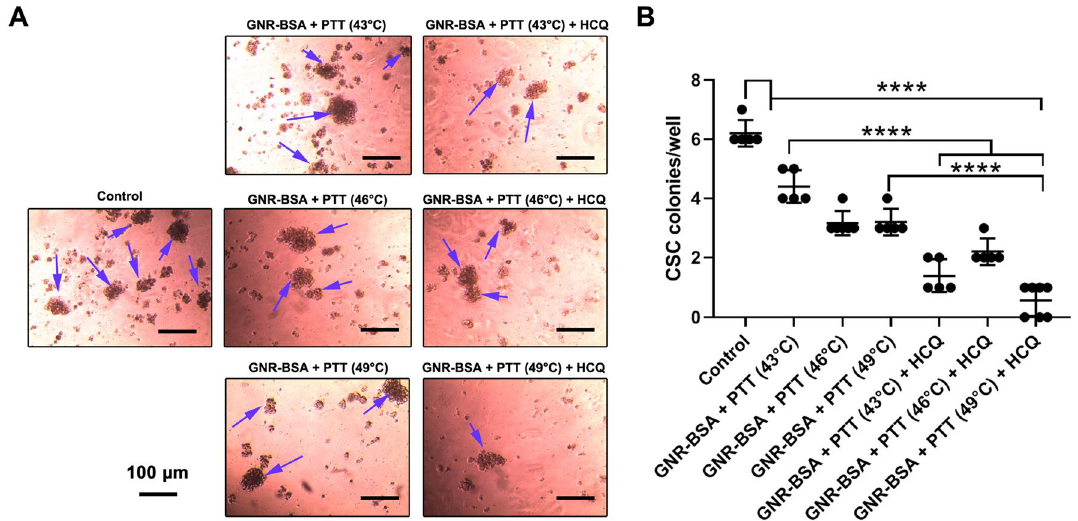
Figure 6. Effect of PTT and PTT + HCQ on CSC spheroid formation. Upon the increase in temperature, the clonogenic capacity of CSCs was reduced compared to the control group (blue arrows). These effects were prominent when the combination of PTT and HCQ was used. One-Way ANOVA and Tukey post hoc analysis. **** p <